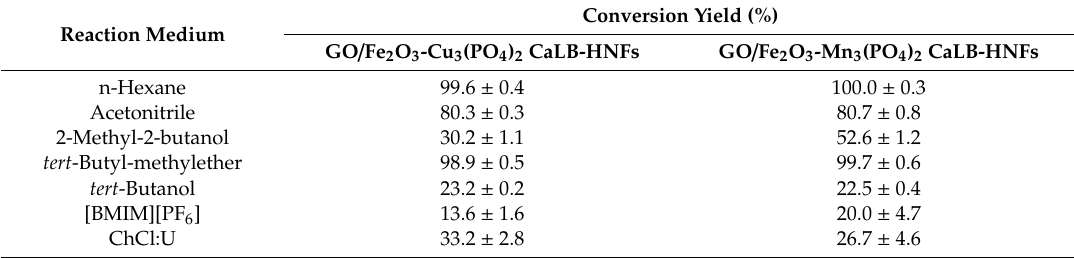
Table 3. Conversion yields for the enzymatic transesterification of tyrosol with vinyl butyrate